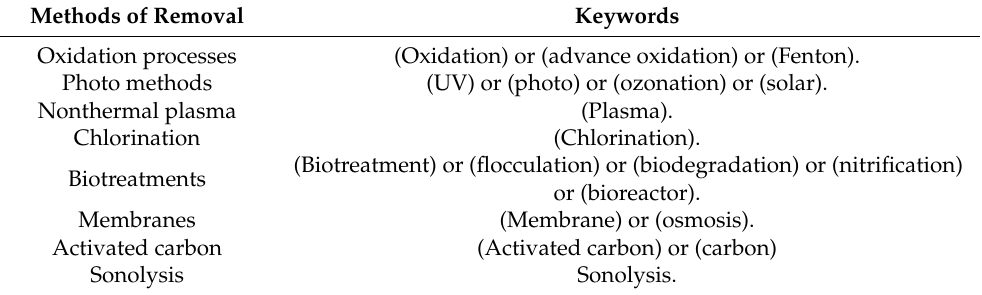
Table 7. Pharmaceutical removal methods in pharmaceutical groups under study in